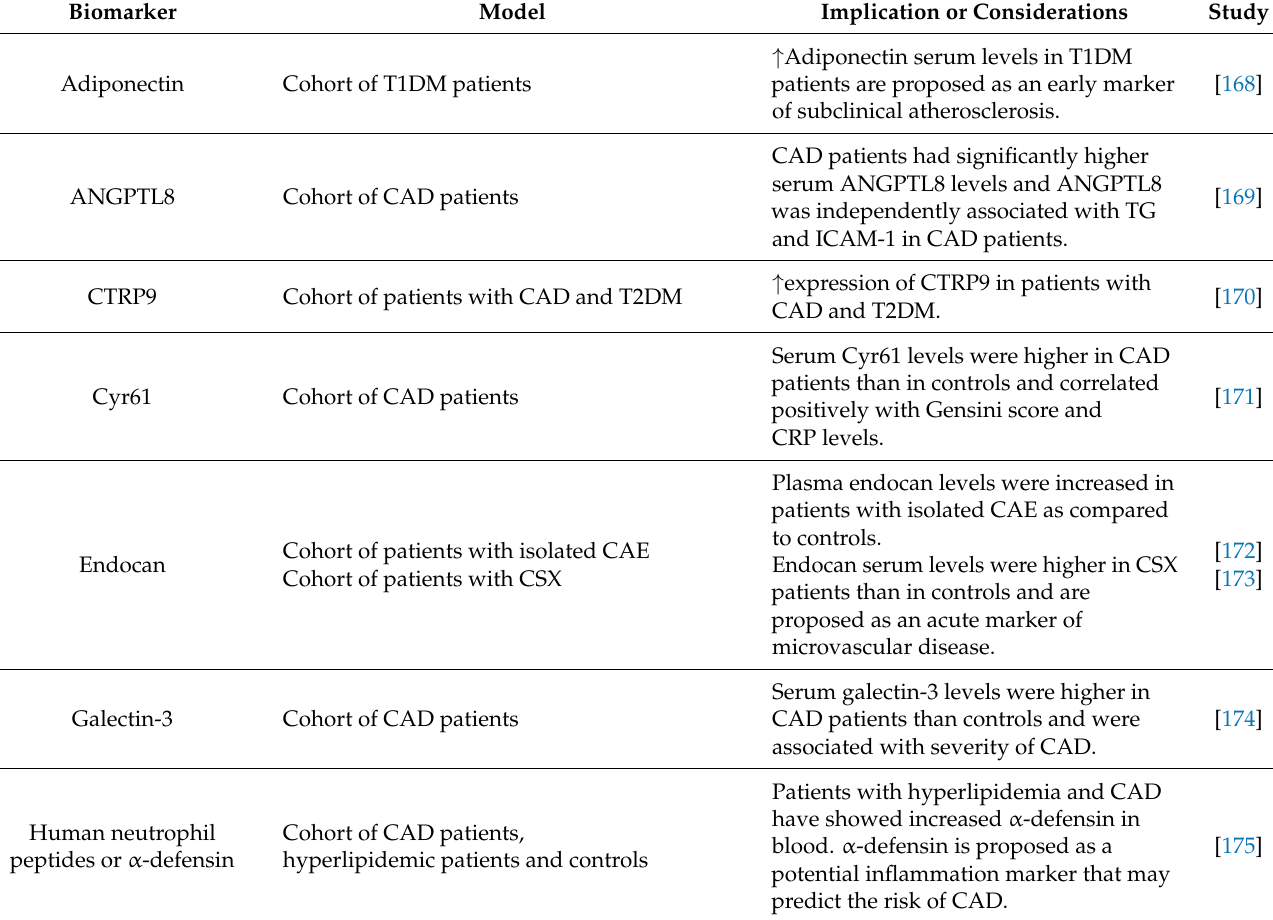
Table 1. Recently identified potential biomarkers of inflammation and endothelial dysfunction in coronary artery disease